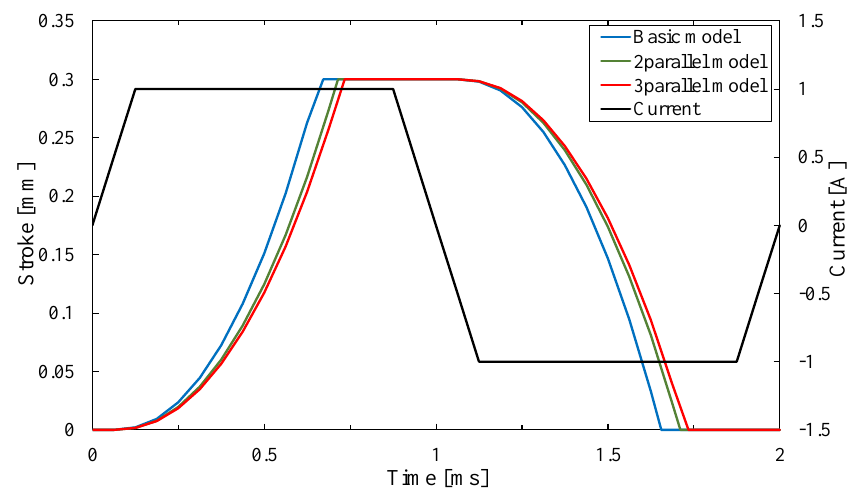
Figure 18. Response waveform of parallel type.